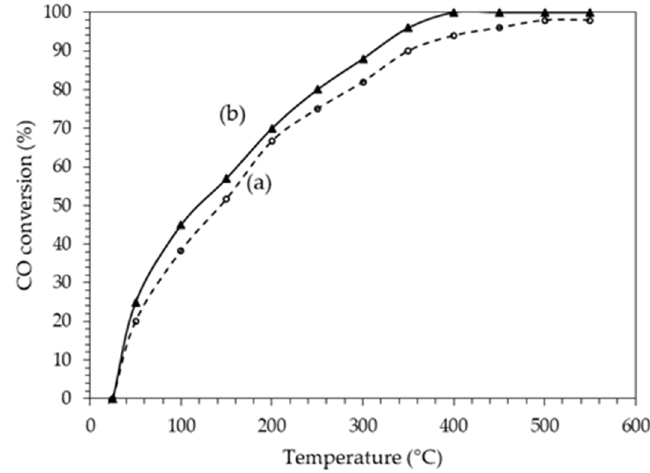
Figure 11. CO conversion of catalysts: ( a ) 2Ag / AW and ( b ) 0.1PtAg / AW. Inlet gas composition: 500 ppm NO, 625 ppm C 3 H 8 , 200 ppm CO, 660 ppm H 2 , 2 vol.% O 2 , N 2 balance; GHSV = 128,000 h − 1 .